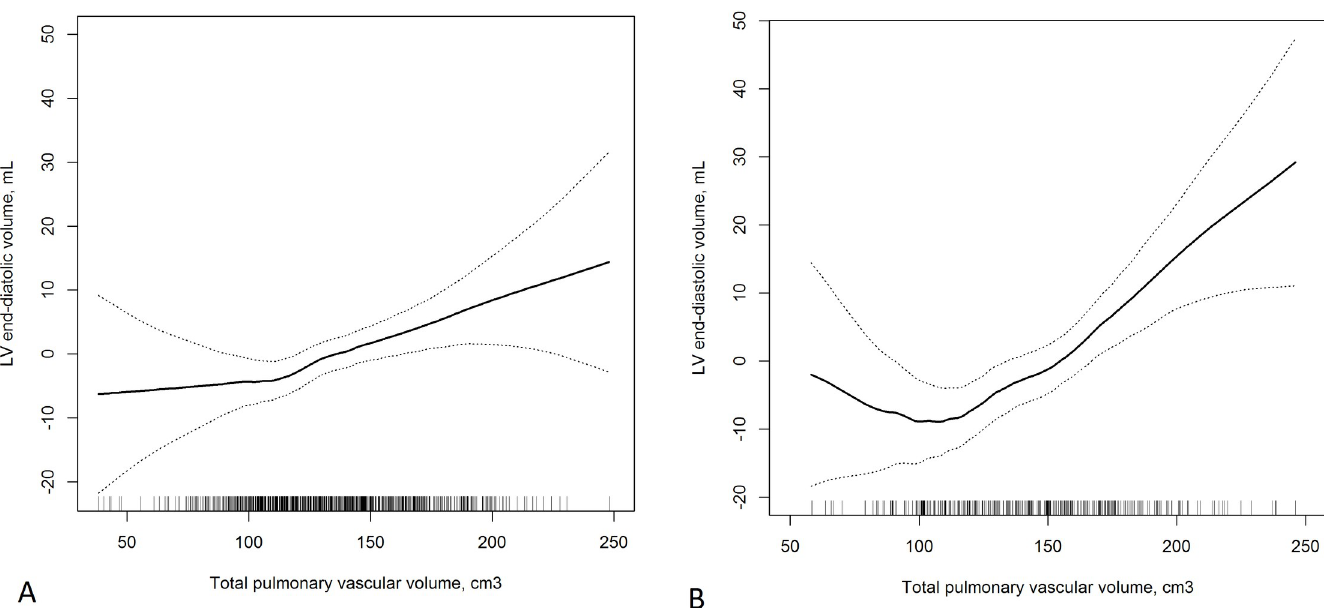
Fig 2. Generalized additive multivariate model of relationship between total pulmonary vascular volume and LV end-diastolic volume among ever-smokers (A) without airflow limitation and (B) with airflow limitation. Results are adjustedfor age, sex, race/ethnicity, height, weight,education, CT scannermanufacturer and milliamperes, current smoking,pack-years, total cholesterol, high densitylipoproteincholesterol, triglycerides, hypertension, systolic bloodpressure,diabetes,fasting glucose,creatinine,diureticuse and percent emphysema. (Missing data for Fig 2 followsa single imputation approach.) PanelA (Without airflowlimitation): N = 771, P-linearity < 0.001, P-nonlinearity = 0.59. Panel B (With airflowlimitation): N = 352, P-linearity= 0.02, P-nonlinearity < 0.001.The increasein LV EDV seen at lower valuesof TPVV flattens after adjustment for LV ejectionfraction.